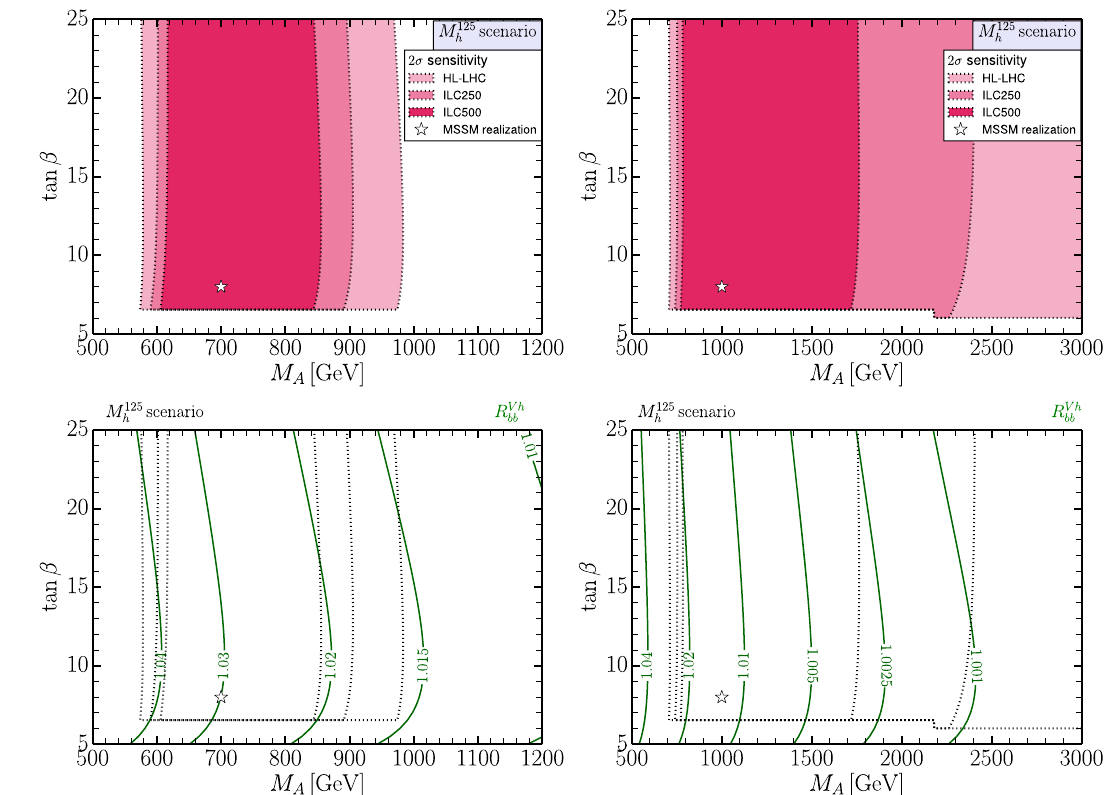
Fig. 8 Upper panels: Indirect 2 σ constraints in the ( M A , tan β ) param- eter plane of the M 125 scenario from prospective Higgs-boson signal- h rate measurements at the HL-LHC (faint red) and in combination with ILC250 (medium red) and ILC500 (bright red) measurements, assum- ing that the point, indicated by a star, ( M A , tan β) = ( 700GeV , 8 ) (left